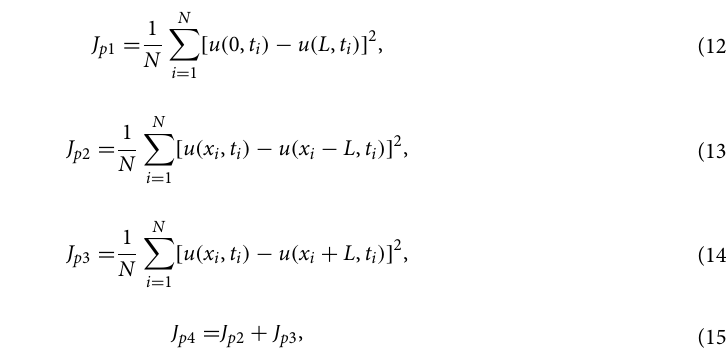
Figure 4. Comparison of training time ( t ) and standard error ( σ ) with two data sampling methods in the PINN with residual units. ( a ) The mixture of GS and RS at α sampling; ( b ) The mixture of GS and LHS, i.e., GLHS, at α sampling. The purple bars on the left represent the standard error of network training results, and the abscissa (0.001–0.5) is amplified by log 10 . The yellow bars on the right represent the time spent on network